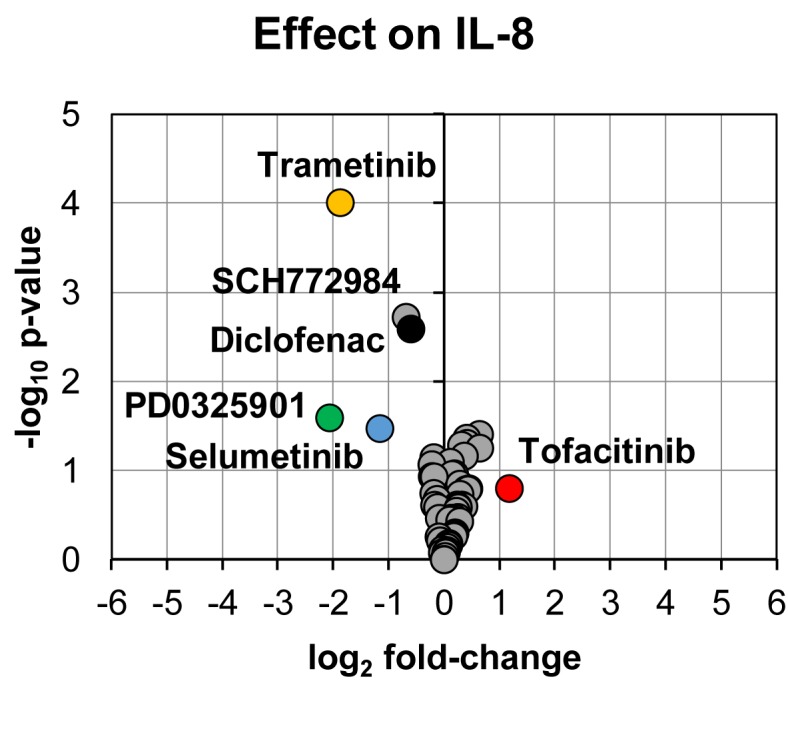
Volcano plot showing effects on IL-8 secretion in LPS-induced human whole blood. The top altered conditions compared to vehicle control based on fold-change (< 0.5 or >2) and p-value (< 0.05) are highlighted. Each inhibitor was tested in 3–13 donors. Statistical significance was tested using one sample t-test (p < 0.05). IL-8, interleukin-8.